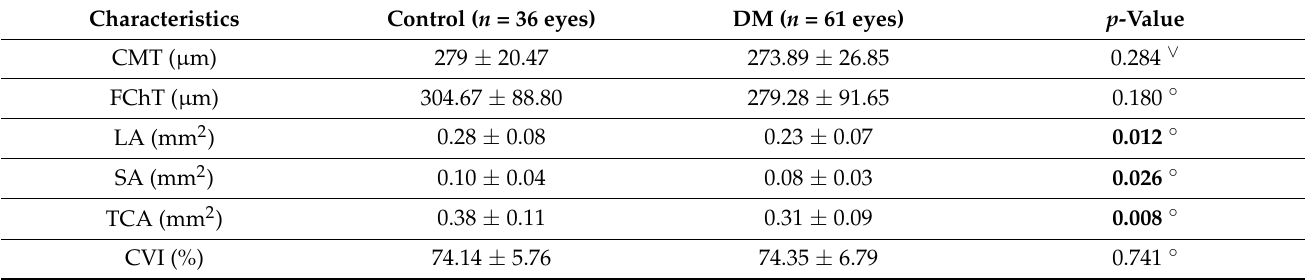
Table 3. Choroidal characteristics and central macular thickness in control group versus DM group. Characteristics